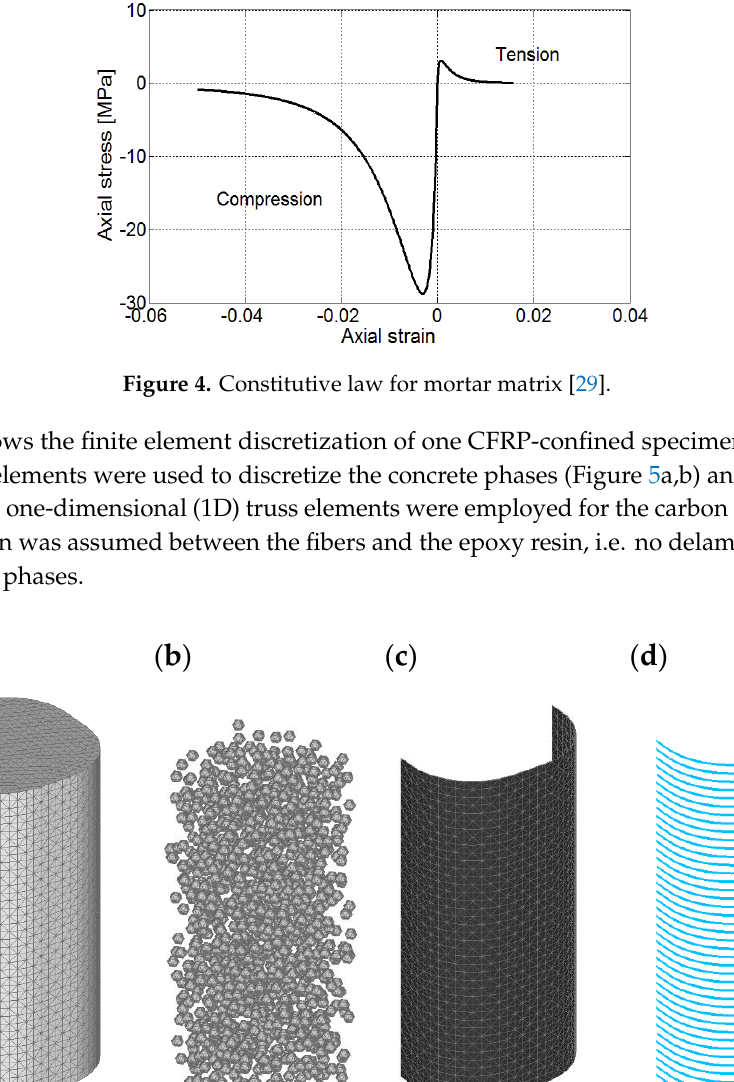
( b ) Figure 3. Constitutive law for: ( a ) Epoxy resin and ( b ) fibers (adapted from [28] ) Regarding concrete, the constitutive law for mortar (Figure 4) is based on the microplane model [26], while a linear elastic behavior was assumed for the aggregate. The mechanical